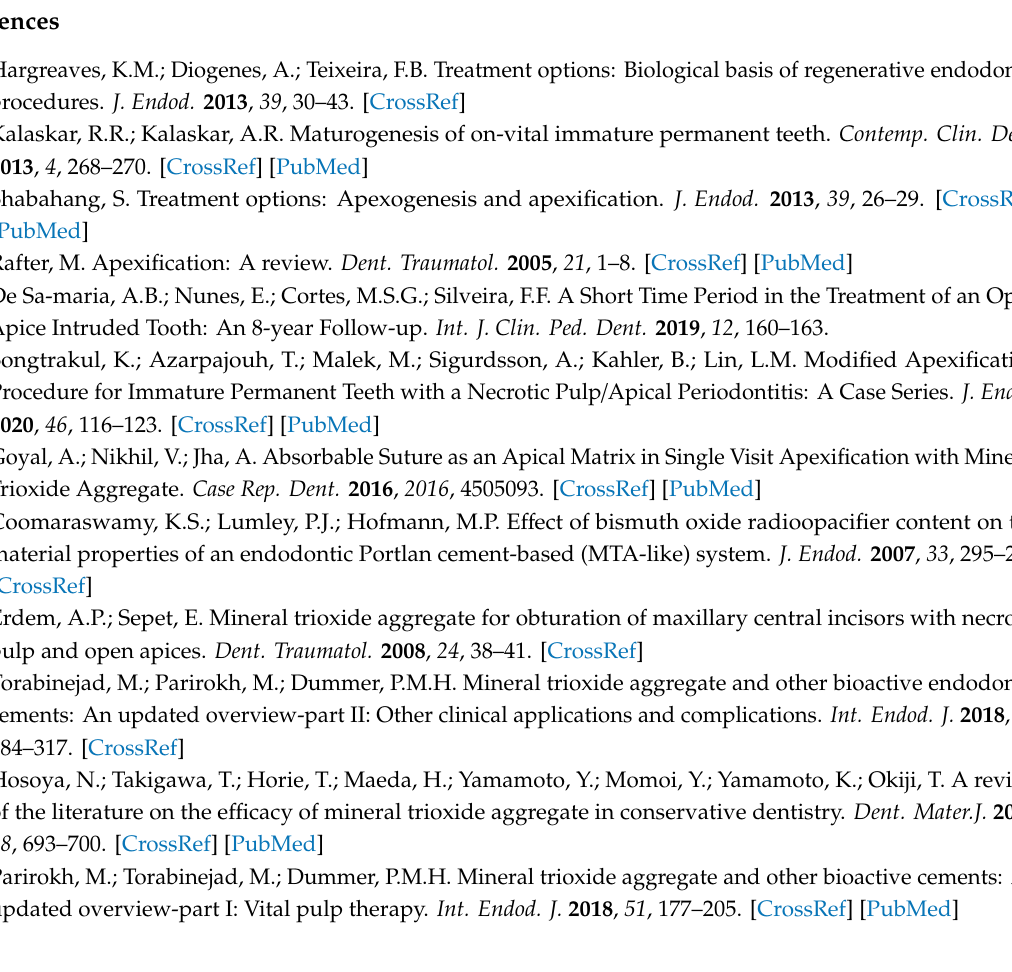
Table S1: Mean and standard deviation values of inhibitions zones at 24 h / 48